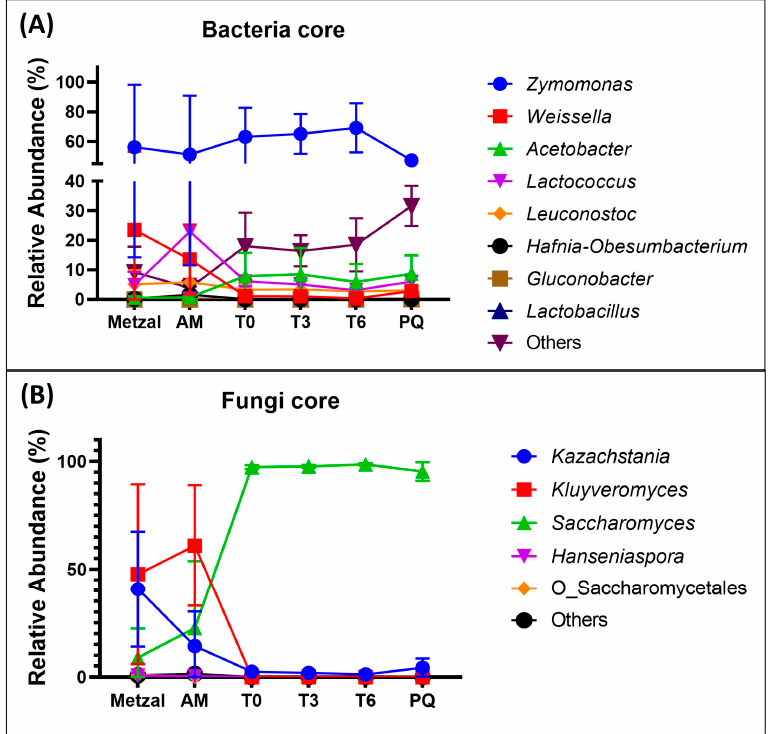
Figure 6. Microbial dynamics of bacterial and fungal core in pulque. ( A ) Bacteria. ( B ) Fungi. The graphics represent the average relative abundance of the three analyzed fermentations. The bacterial and fungal diversity associated with the plant tissue (metzal) of the walls of the cajete and in the sap that accumulated in the cavity after the walls are scraped during the daily process of extraction of AM could be considered as plant-associated di- versity, which includes the OTUs considered as the bacterial and fungal core proposed for PQ. Several OTUs included in the Others group were absent in metzal but detected in AM and during all the fermentation stages. These microorganisms include Lactobacillus acetotolerans , L. brevis , L. camelliae , and L. hilgardii . In contrast, other OTUs were detected during all the fermentation stages (T0, T3, T6, and overnight fermented PQ), including Lactobacillus senioris , L. similis , an uncultured Lactobacillus , and two OTUs identified as Acetobacter (Supplementary Table S1). These findings indicate that these minor abundant bacteria could be incorporated into the sap from sources other than the metzal and incor- porated into the fermentation as part of the seed used to start the fermentation. For fungi, among the 13 OTUs detected in the metzal, five of them are part of the core of the beverage, while the remaining eight (included in the Others group) were only de- tected in the metzal and AM: Aurebasidium_pullulans , Penicillium sp., Turolospora delbruekii , Rectipilus sp., Malassezia globosa , M. restricta , and the OTUs O_Hypocreales and O_Agarica- les . The remaining OTUs identified (five) were only detected in the AM: Botrytis_carolini- ana , Erytrobasidium hasegawianum , Naganishia albida , and the OTUs p-Ascomycota and k- Fungi, also suggesting that these minor fungi could be incorporated into the sap from sources other than the metzal. 4. Discussion The analysis of the microbial diversity responsible for the fermentation of the tradi- tional Mexican pulque beverage has been studied by diverse authors [9–12,23–27]. Recent